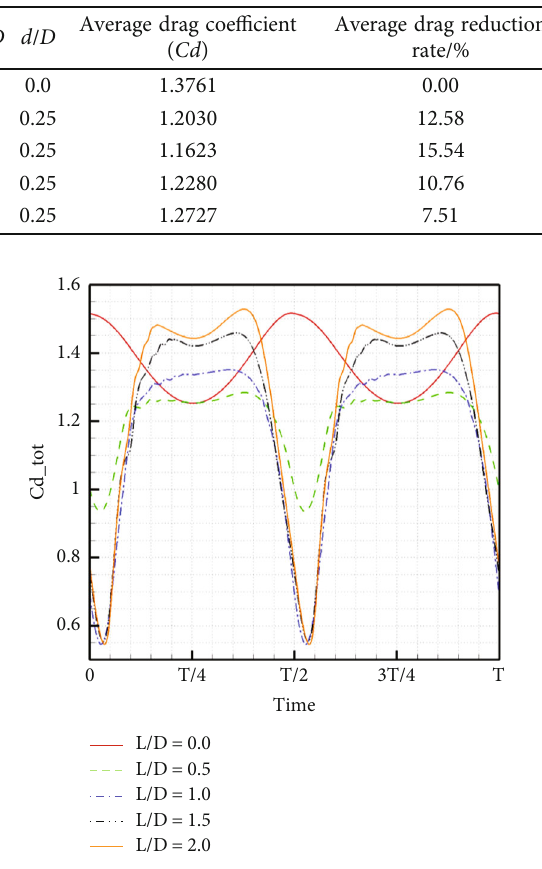
Figure 9: Development of the drag coe ffi cient with di ff erent L / D